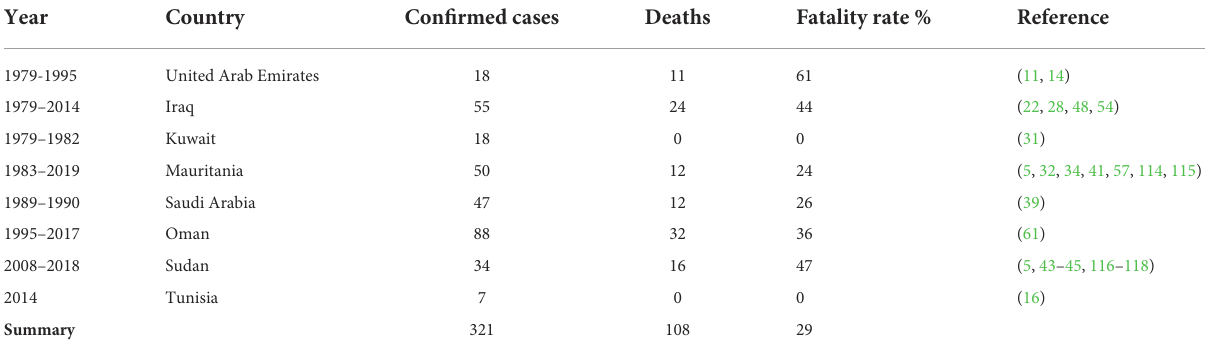
TABLE 2 Summary of CCHF outbreaks/reports in the Arab